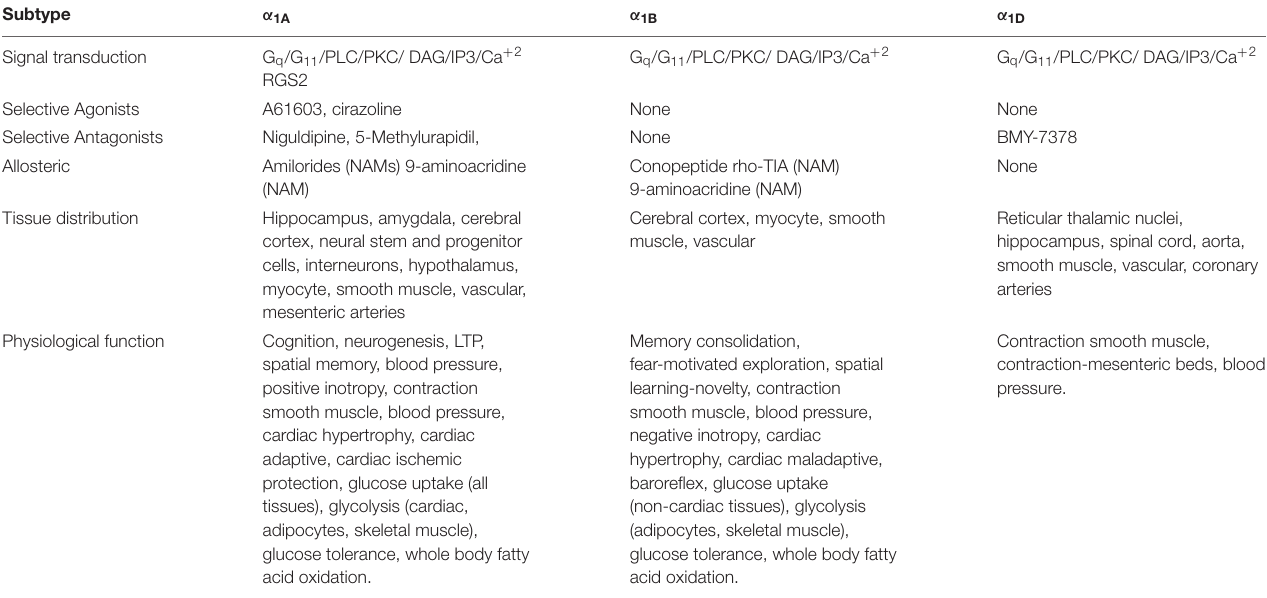
TABLE 1 | Properties of the α 1 -AR